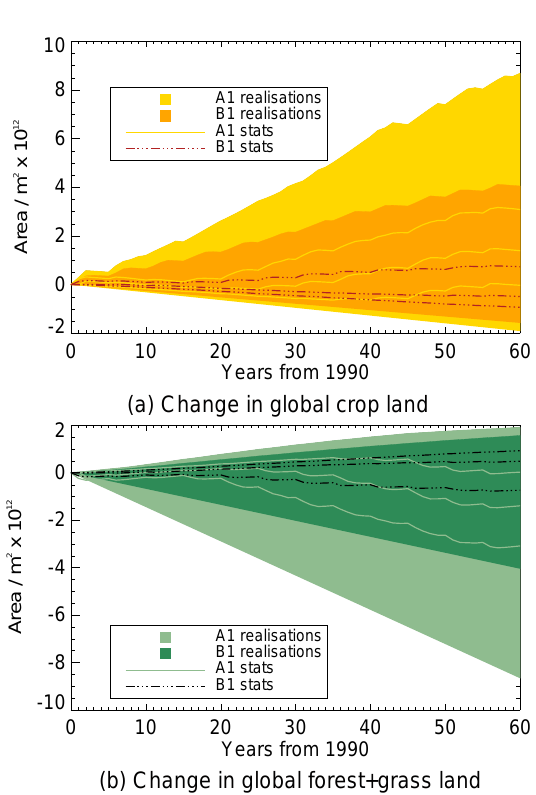
Fig. 2. Ensemble ( n = 1000) change in (top) total global cropland (10 12 m 2 ) from 1990 to 2050 (bottom) global forest + grassland (10 12 m 2 ) for A1 and B1 SRES scenarios (Table 1). The “stats” lines denote the median, upper and lower quartiles for each ensem-